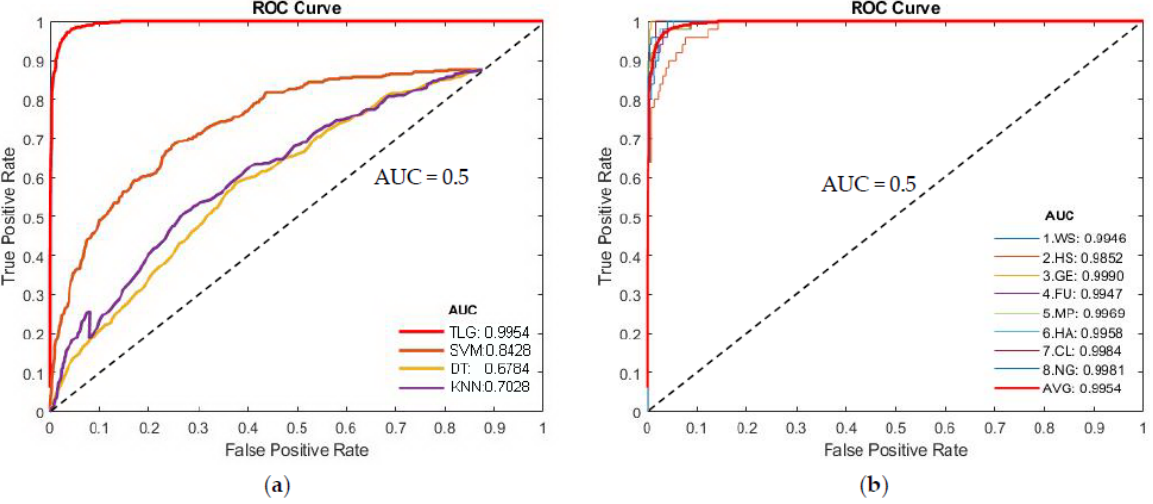
Figure 9. Receiver operating characteristic (ROC) curve. ( a ) Test assessment for the four classifier models. ( b ) Test assessment for different types of geothermal surface manifestations (GSMs) by the GoogLeNet model. AUC means the area under the curve. TLG denotes transfer learning with the pretrained GoogLeNet; SVM denotes the Support Vector Machine algorithm; DT denotes the Deci- sion Tree algorithm; and KNN denotes the K-Nearest Neighbor algorithm. WS denotes warm spring; HS denotes hot spring; GE denotes geyser; FU denotes fumarole; MP denotes mud pot; HA denotes hydrothermal alteration; CL denotes crater lake; NG denotes none of GSMs; and AVG de- notes the average of all AUC values of the eight types of GSMs.